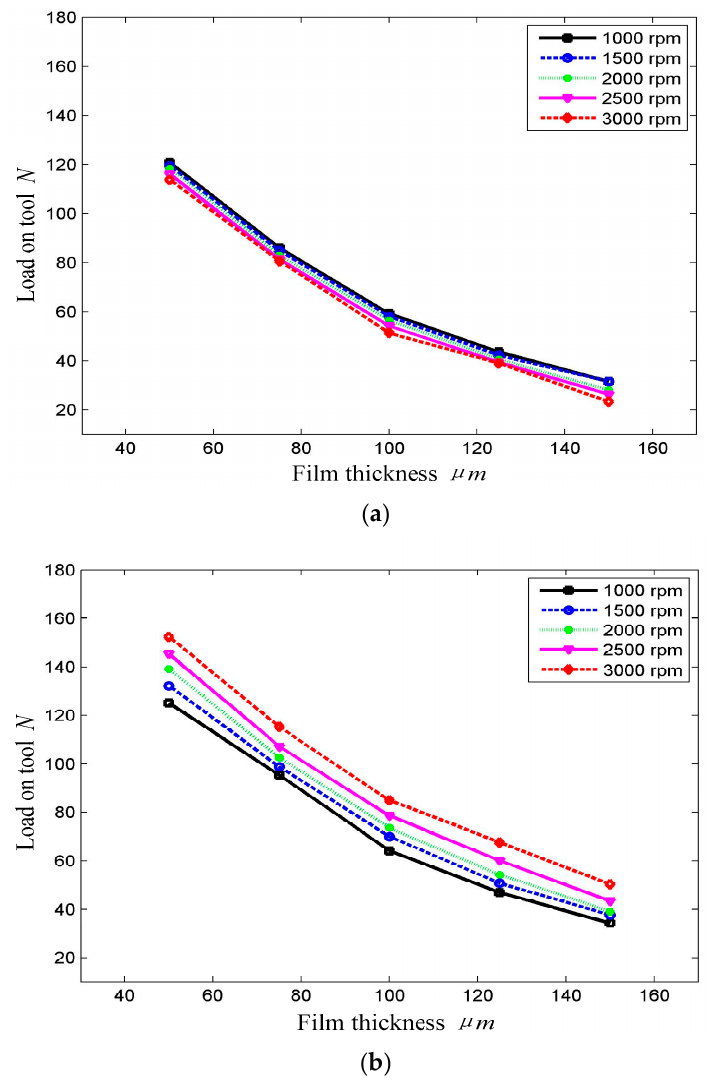
Figure 9. Influence of rotation on load–thickness curve. ( a ) Without grooves; ( b ) With pressure groove.